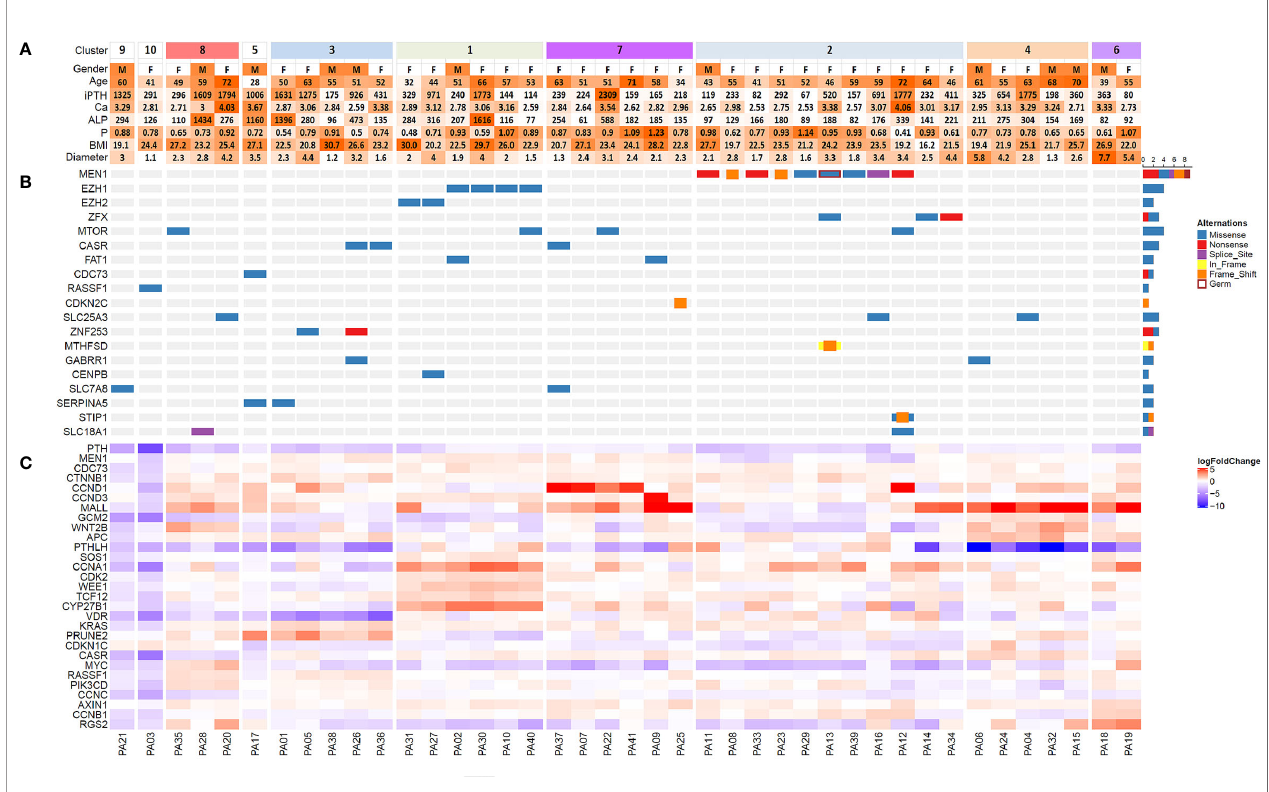
FIGURE 1 | Heatmap of clinical features (A) , signi fi cantly mutated genes (B) and differentially expressed genes (C) among 41 patients with parathyroid adenoma. Samples were clustered based on RNA-seq data by unsupervised clustering with the ConsensusClusterPlus package. Sample numbers are shown below the corresponding columns. In part (C) the logarithm of fold change in gene expression compared with the expression levels in normal parathyroid tissue is visualized by color intensity. Upregulation and downregulation of gene expression are represented by red and blue, respectively. iPTH, serum intact PTH level (12-67 pg/ml); Ca, serum calcium level (2.13-2.70 mmol/L); P, serum phosphorus level (0.81-1.45 mmol/L); ALP, alkaline phosphatase (35-100 U/L); BMI, body mass index; Diameter, maximum diameter of the tumor